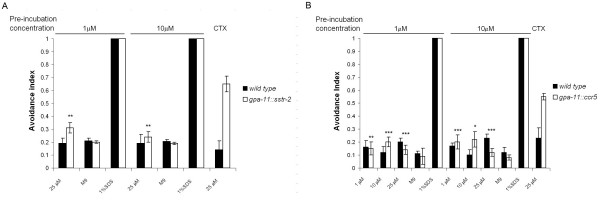
Sstr2 and CCR5 transgenic animals mutants are desensitised by pre-exposure to agonists. (A) Pre-exposure of Sstr2 transgenic animals to 1 μM and 10 μM SST-28 prior to the assay strongly reduced or even abolished avoidance behaviour. (B)Pre-exposure of CCR5 transgenic animals to 1 μM and 10 μM MIP-1α fully abolished avoidance of 1 μM, 10 μM and 25 μM MIP-1α. In both cases, pre-exposure to the agonist did not affect the responses towards other repellents. Animals were washed in buffer as control. For each panel, each data point represents an average of at least five independent assays for wild type and each respective strain. Error bars denote the standard error of the mean. Asterisks indicate a statistically significant difference between transgenic animals pre-exposed to agonist or only to chemotaxis (CTX) buffer (*p ≤ 0.05, **p ≤ 0.01, ***p ≤ 0.005).